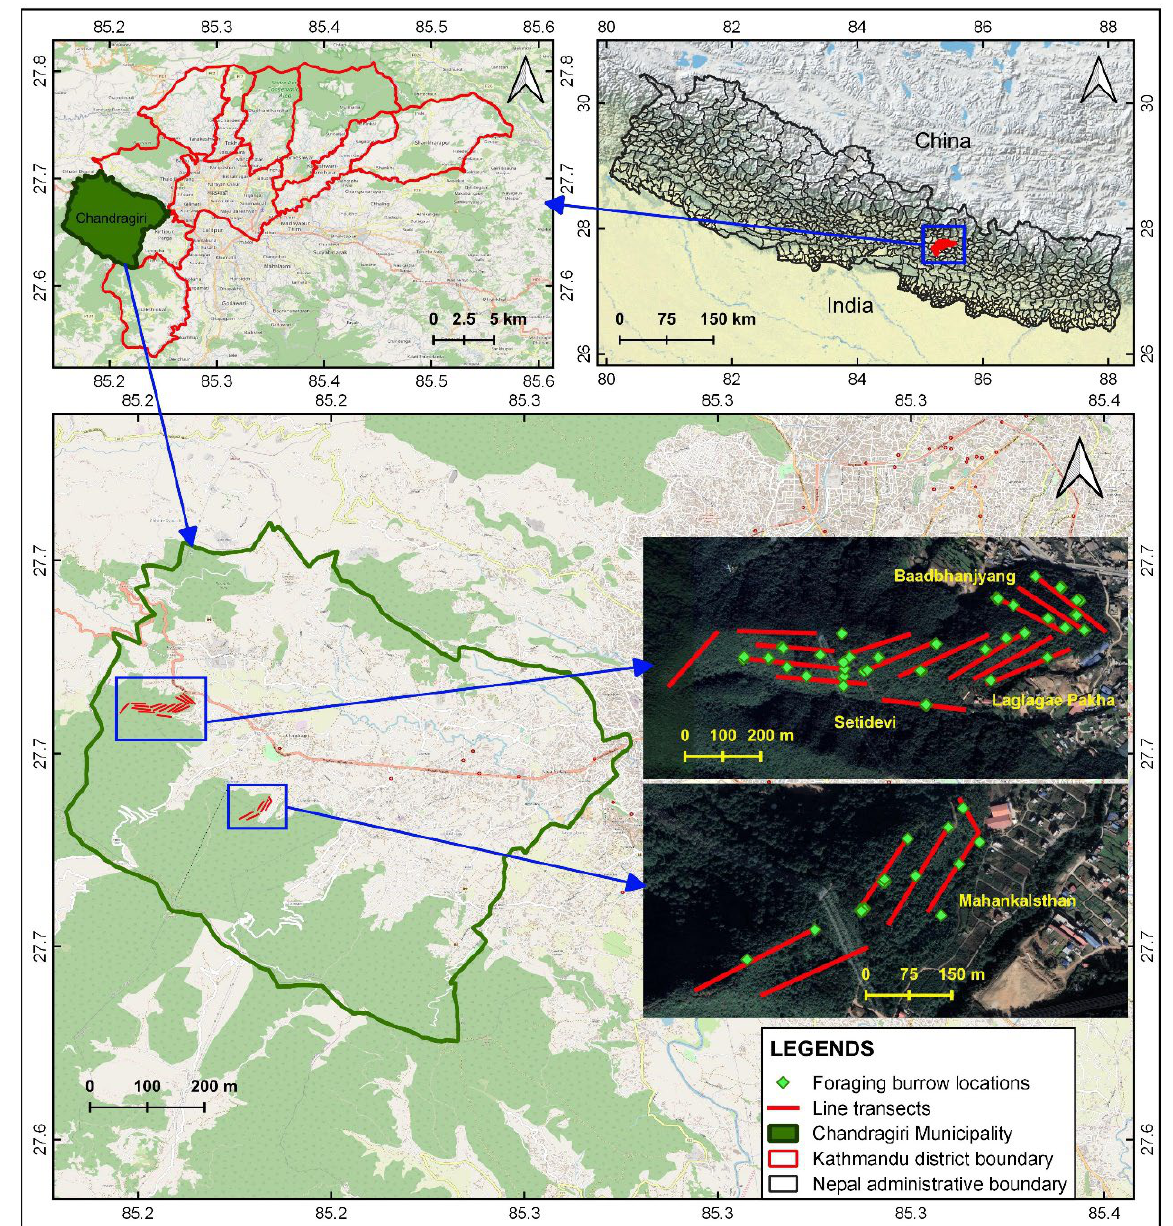
Figure 1. Chinese pangolin study area with established line transects and foraging burrows in Chandragiri Municipality, Nepal.